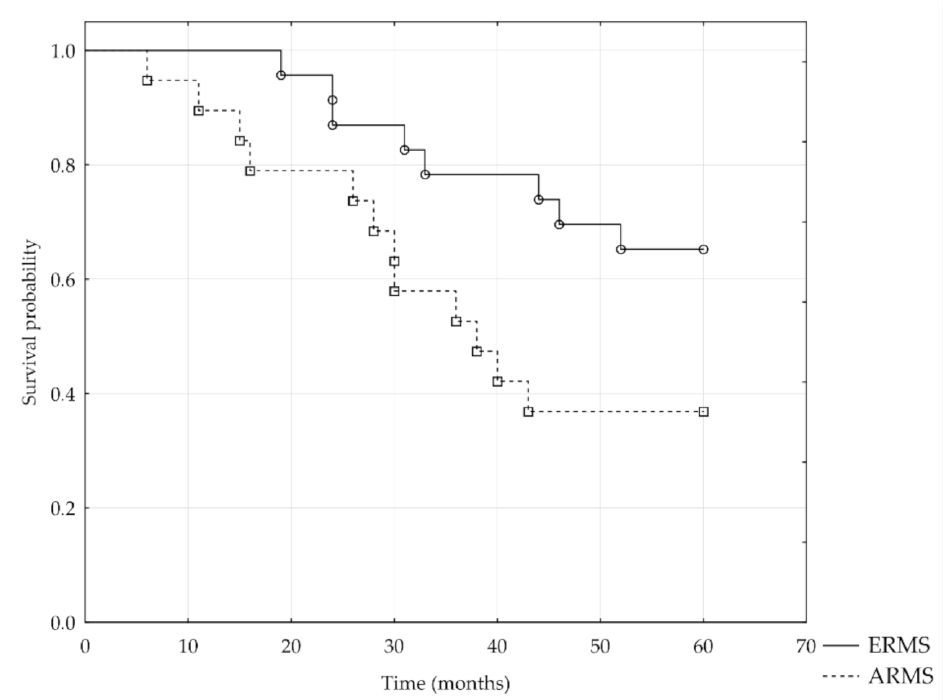
Figure 4. Kaplan–Meier analysis of the 5-year overall survival for patients with ERMS and ARMS.